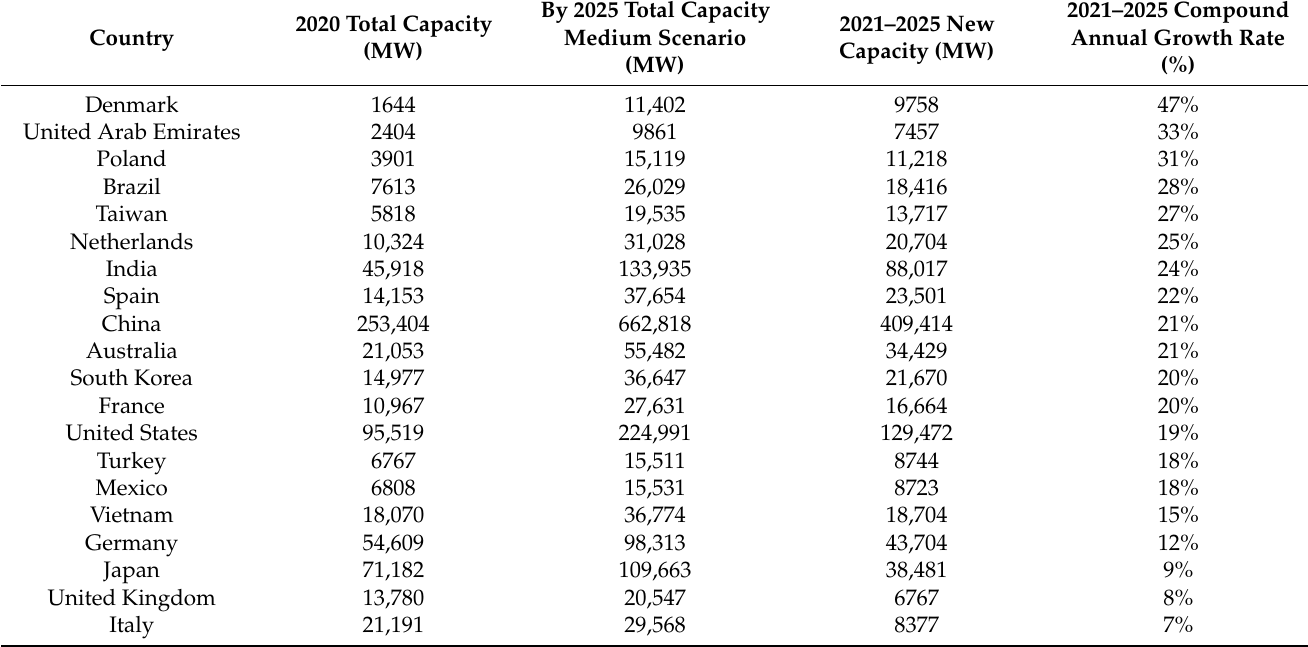
Table 1. Poland’s place in the PV development forecast until 2025.